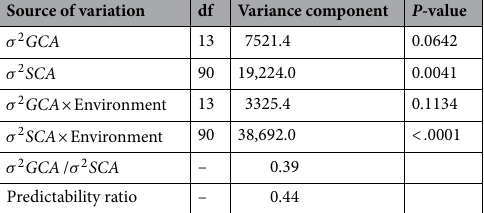
Source of variation df Variance component P -value σ 2 GCA 13